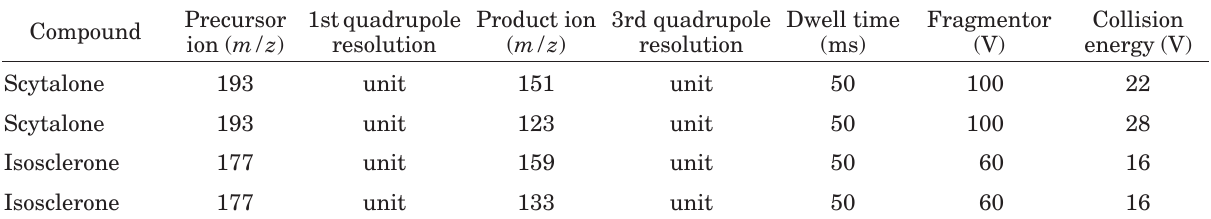
Table 1. Conditions used for MS/MS detection of scytalone in Phaeoacremonium aleophilum culture filtrate. At these analytical conditions the limit of detection (LOD) and limit of quantitation (LOQ) were 1 µ g L -1 and 5 µ g L -1 , respectively, as established by spiking known amount of analytes in a previously analyzed (negative) blank sample pool.